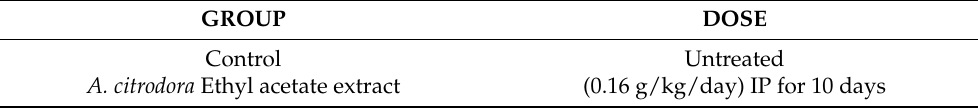
Table 10. In vivo experimental groups and the treatments received. GROUP DOSE Control Untreated A. citrodora Ethyl acetate extract (0.16 g/kg/day) IP for 10 days n = 9 for each